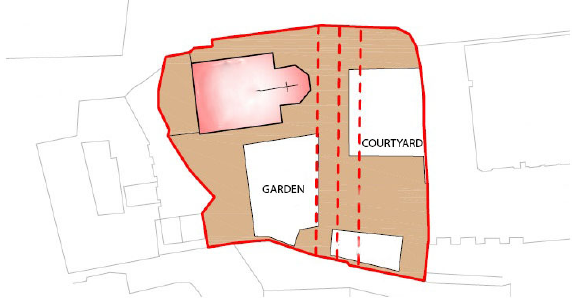
Figure 3. Carmel Monastery: Proposed remedial measures.